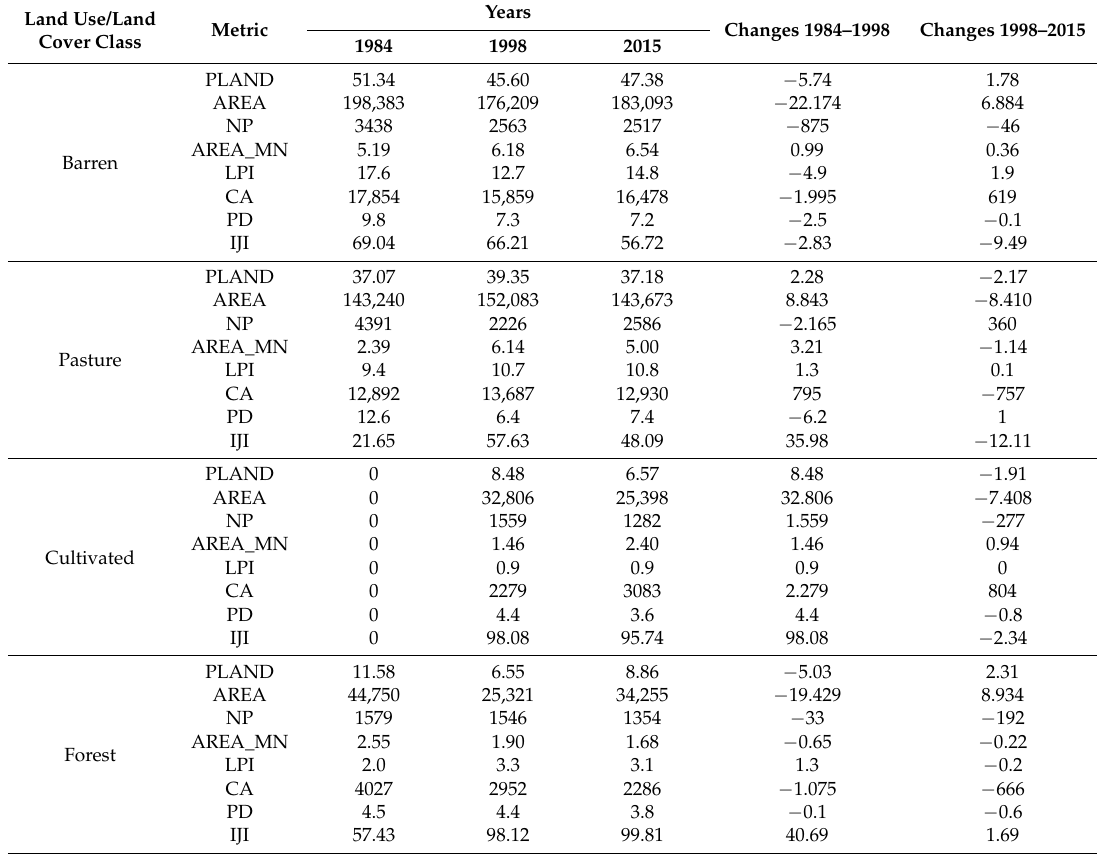
Figure 3. Random Forest Classification for HSCZ for ( a ) 1984; ( b ) 1998; and ( c ) 2015. Table 4. Values of class land percentage, area, patch number, mean patch size, largest patch index, class area, patch density, and the interspersion and juxtaposition at the class level for the HSCZ in 1984, 1998, and 2015. and Land Use/